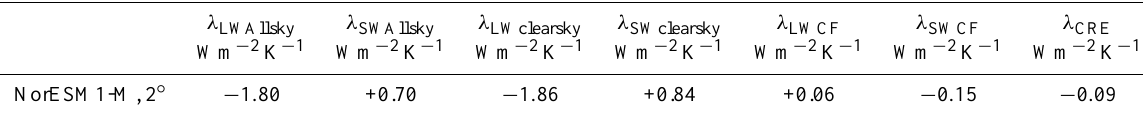
Table 2. Global gross feedback response ( λ X ) in TOA radiation parameters ( X ) as determined by linear regression of model simulated annual change ( 1X ) with respect to the corresponding annual surface air temperature change ( 1T ) after abrupt 4 × CO 2 . The quantity λ X = d (1X)/ d (1T ) , and X is long-wave (LW) and short-wave (SW) all-sky and clear-sky TOA outgoing radiation, long-wave (LWCF) and short-wave (SWCF) cloud forcing, or net cloud radiative effect (CRE). λ LWAllsky λ SWAllsky λ LWclearsky λ SWclearsky λ LWCF